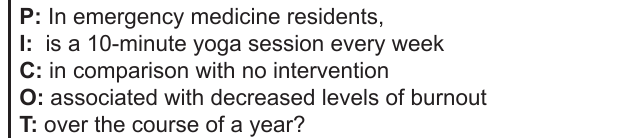
Figure 2. FINER criteria for assessing study questions. FINER , feasible, interesting, novel, ethical, relevant; IRB, institutional review